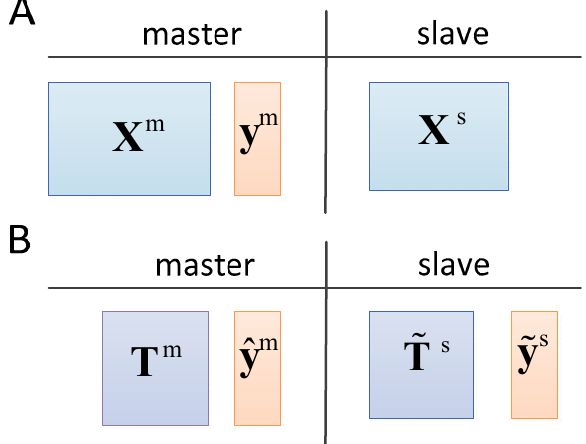
Figure 1. Data setting of the calibration transfer method based on affine invariance without transfer standards (CTAI). We assume the data to be available in ( A ), and the data after being processed based on PLS model of the master instrument is shown in ( B ).